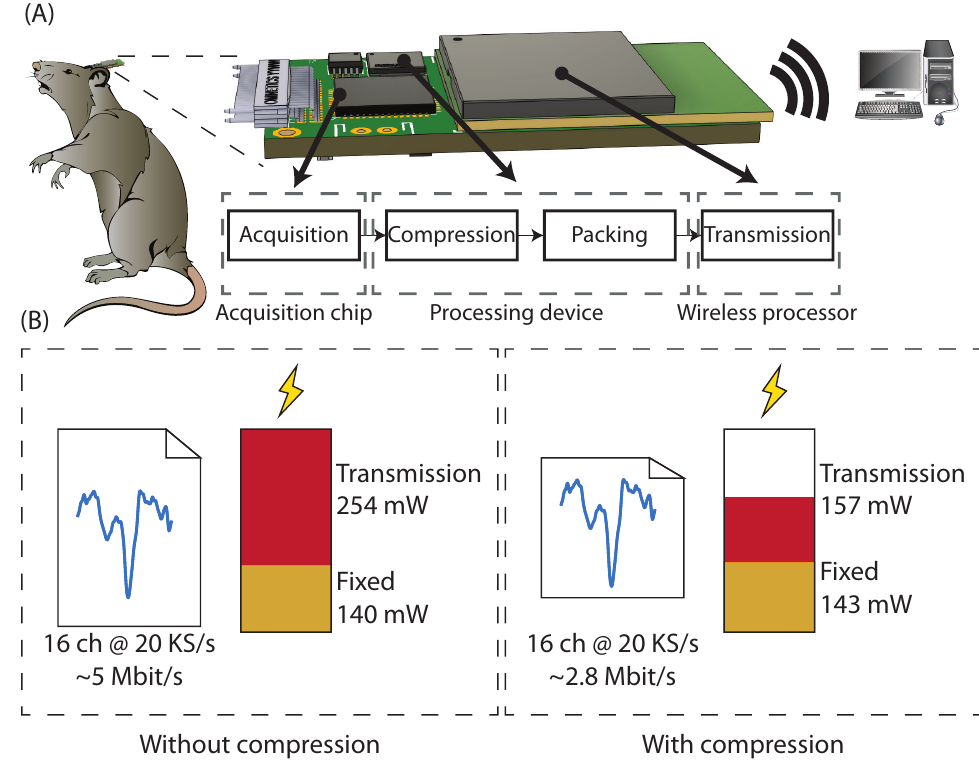
Figure 1. ( A ) General overview of the system and the built prototype. ( B ) Differences of power and bandwidth requirements of the prototype with and without enabling